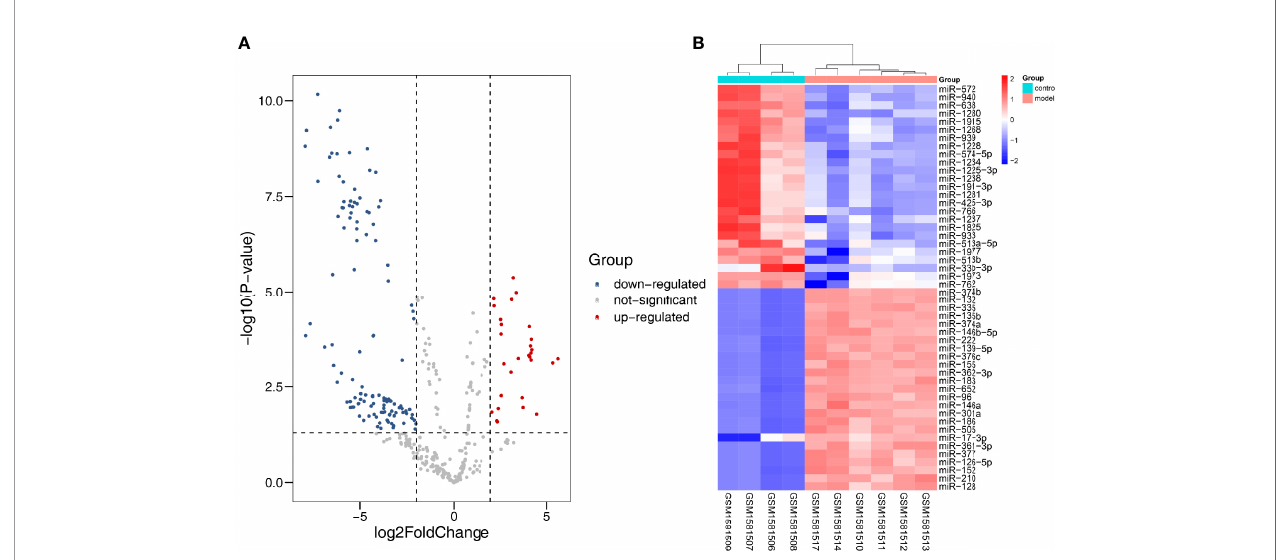
FIGURE 6 | Differentially expressed miRNA in DN. (A) Red dots indicate upregulation, blue dots indicate downregulation, and gray dots indicate no differential expression. (B) Red represents upregulation, and blue represents downregulation.